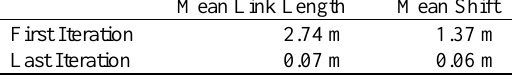
Table 3. Results for first and last iteration step for the